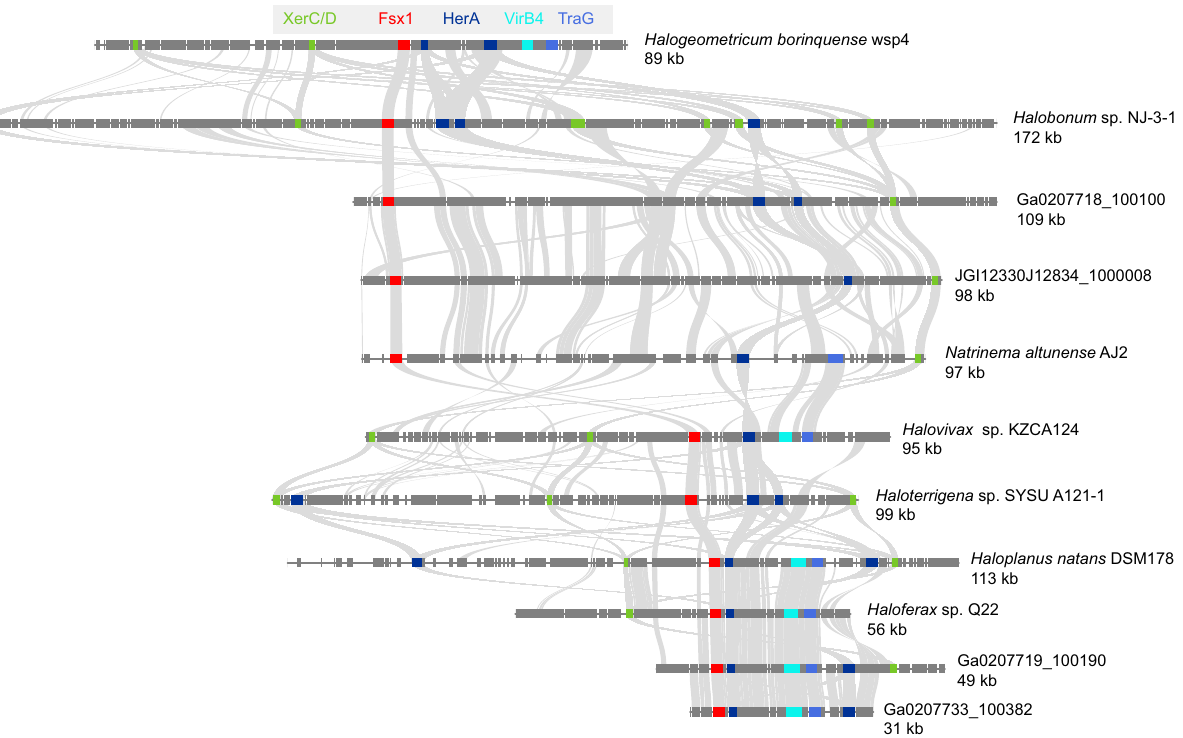
Fig. 8 Fsx1s are embedded in integrated mobile elements (IMEs). Synteny plots for IMEs from PCGs and metagenomic data. Annotated regions plus inferred ORFs belonging to homologous clusters identi fi ed by the work fl ow depicted in Supplementary Fig. 8. Homology relationships are represented by gray links. fsx1 genes are marked in red and selected ORFs homologous to IME signature genes are labeled and color-coded. XerC/XerD recombinases (green); HerA helicase (dark blue); VirB4, Type IV secretion system (T4SS) pathway (cyan); TraG/TraD/VirD4 family enzyme, ATPase, T4SS (see Supplementary Table 3 and Supplementary Data 2, 3 for details). The 11 segments analyzed correspond to the cluster marked in Supplementary Fig.